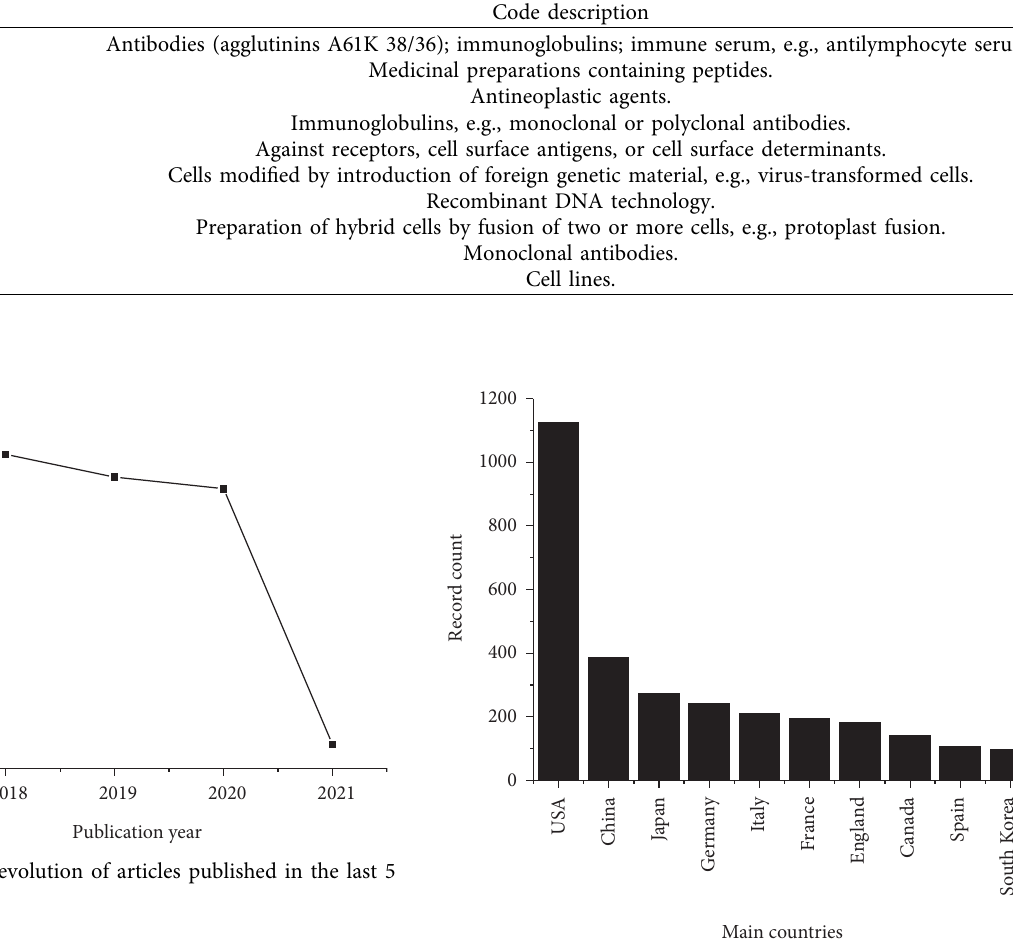
Figure 11: Top 10 countries that most contribute in terms of number of